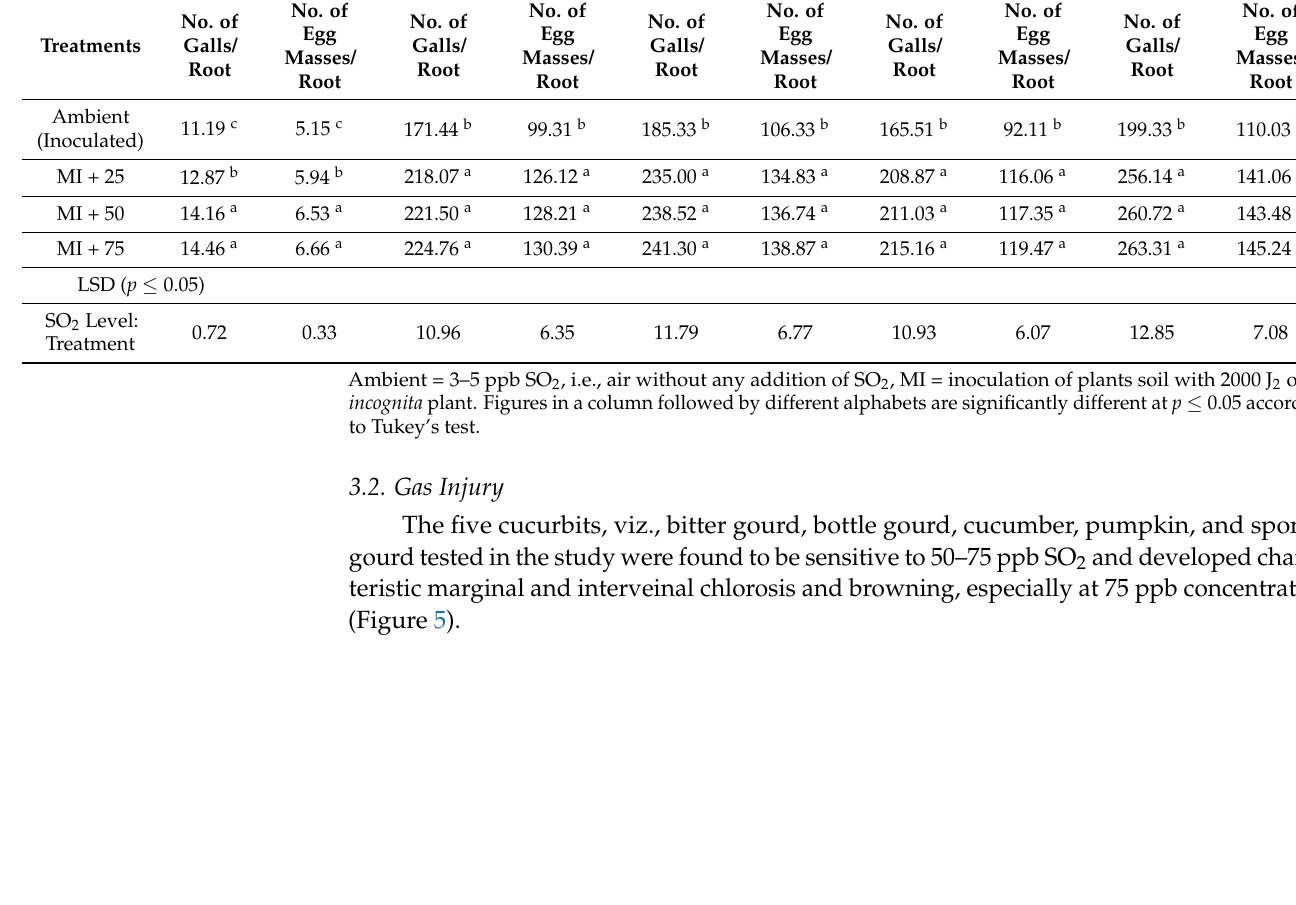
Figure 4. Effect of SO 2 levels on galling of M. incognita in pumpkin. The contrasts located on the right side of the line of no difference represent positive interaction (synergistic). The contrasts situated at the furthest location show highest interaction effect.